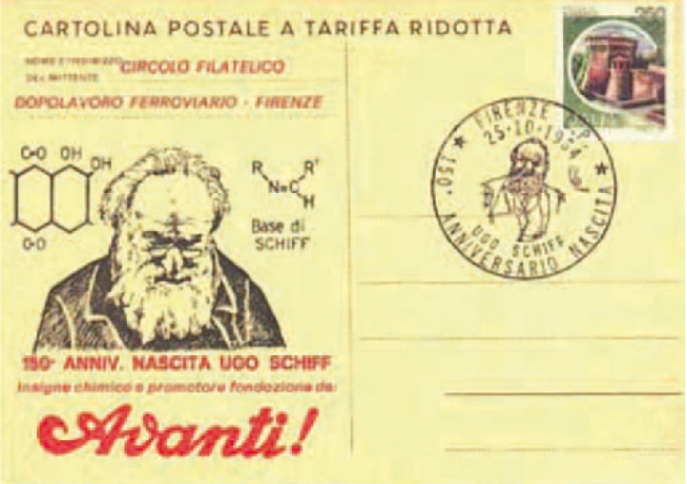
Figure 2. A commemorative Postal card celebrating the 150th anniversary of Ugo Schiff’s